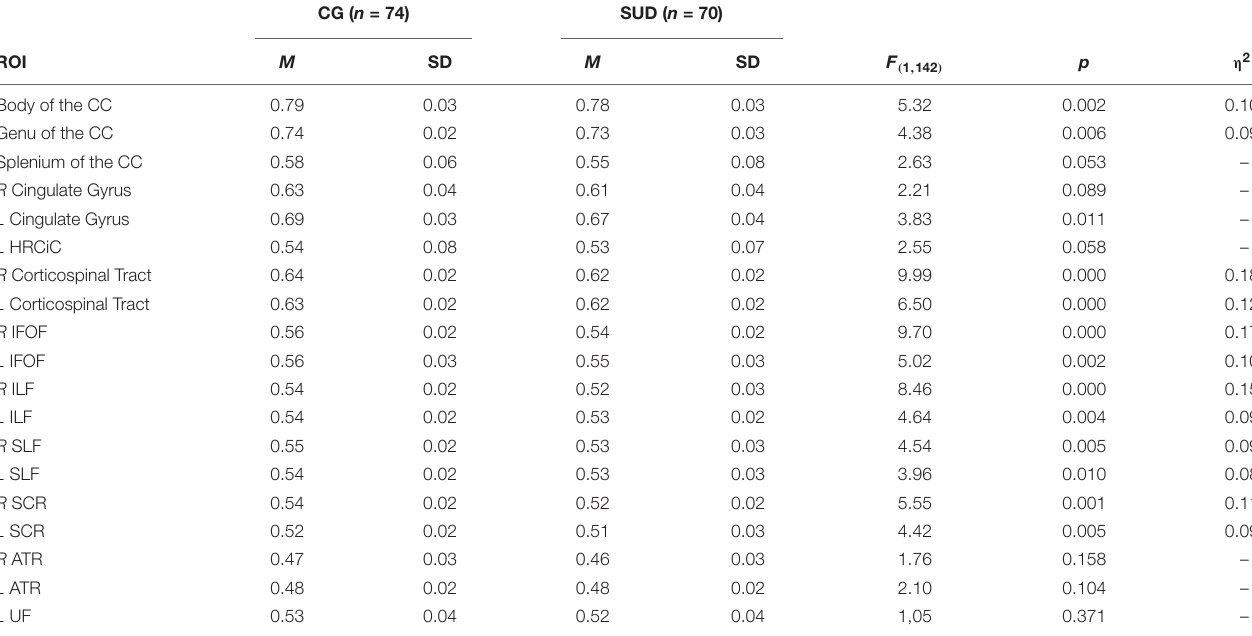
TABLE 4 | Group differences (ANOVA) in FA in selected ROIs, controlled for age, and cognitive